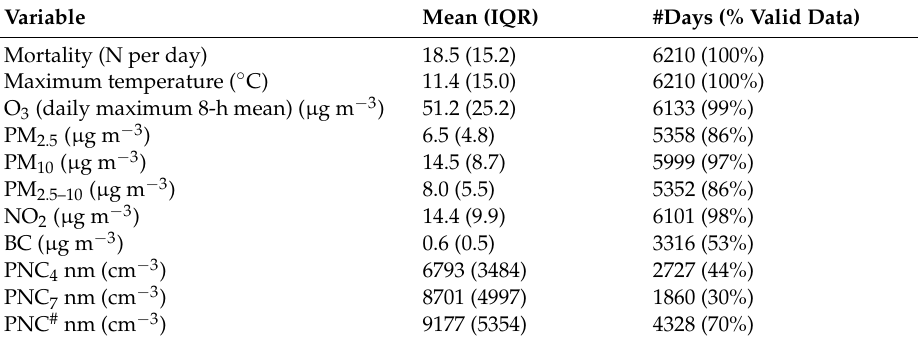
Table 1. Summary statistics of the daily data from 2000–2016 that were used for the study.